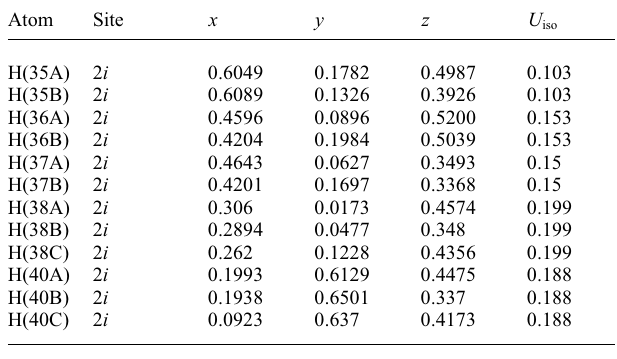
Table 3. Atomic coordinates and displacement parameters (in Å 2 )